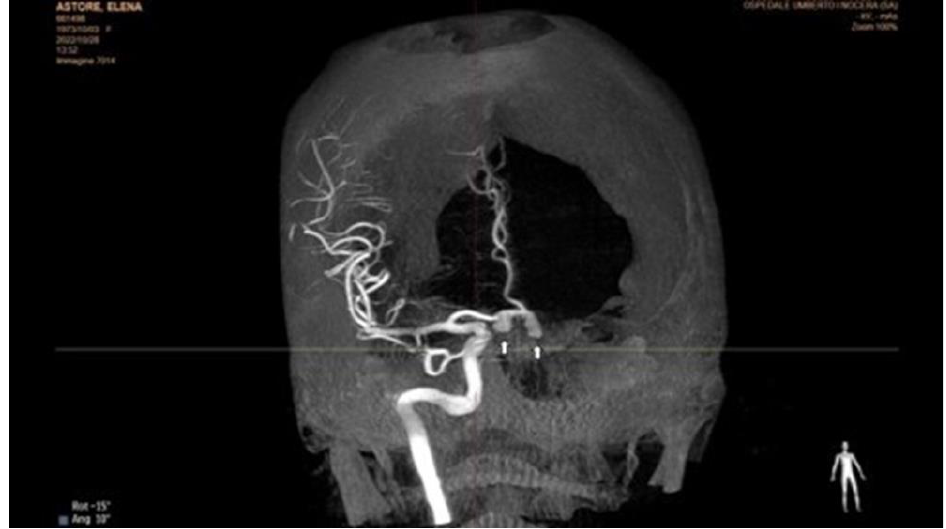
Figure 2. Selective rotational angiography of the right internal carotid artery. The exam shows two aneurysmal dilatations, one of which is sac-shaped in the portion of the right midsection, and the second in correspondence with the ipsilateral A1 – A2 angle. Both have the bottom of the aneurysm directed downwards. The first extension has a large collar, and the second of 1 – 2 mm.